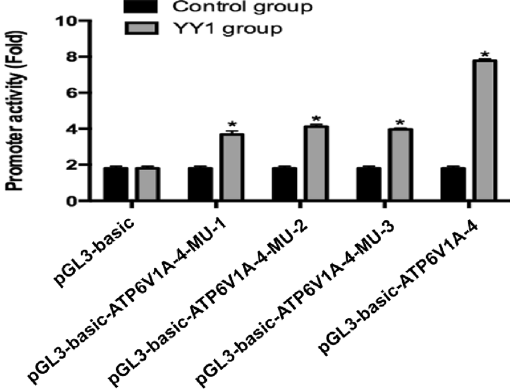
Figure 5. YY1 increases ATP6V1A transcriptional activity in GC cells. Plasmid piRES2-EGFP-YY1 was co-transfected into HGC27 GC cells with a plasmid containing pGL3-basic-ATP6V1A-4 or its mutant. In comparison with the negative control transfected with the plasmid pGL3-basic, the ATP6V1A promoter activity was significantly increased after transfected with piRES2-EGFP-YY1 with pGL3-basic-ATP6V1A-4, pGL3- basic-ATP6V1A-4-MU-1, pGL3-basic-ATP6V1A-4-MU-2 and pGL3-basic-ATP6V1A-4-MU-3, respectively. Moreover, the ATP6V1A promoter activity was much higher in those cells transfected with the plasmid pGL3- basic-ATP6V1A-4 harboring the complete promoter fragment than those plasmids with deletion constructs, including pGL3-basic-ATP6V1A-4-MU-1, pGL3-basic-ATP6V1A-4-MU-2 and pGL3-basic-ATP6V1A- 4-MU-3. The values represent means ± SEM. n = 3, * p <